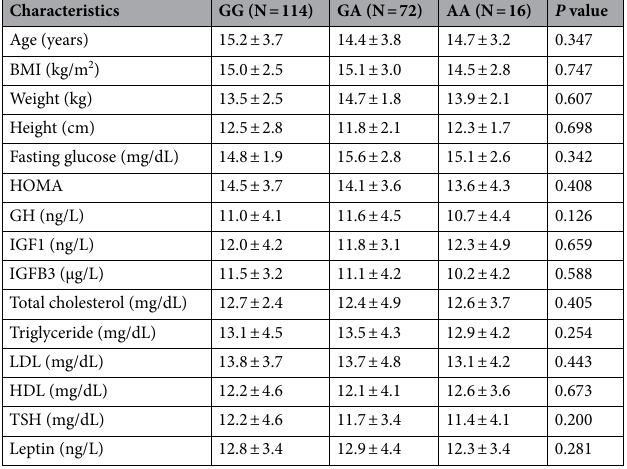
Table 1. Basic characteristics of different patient groups.